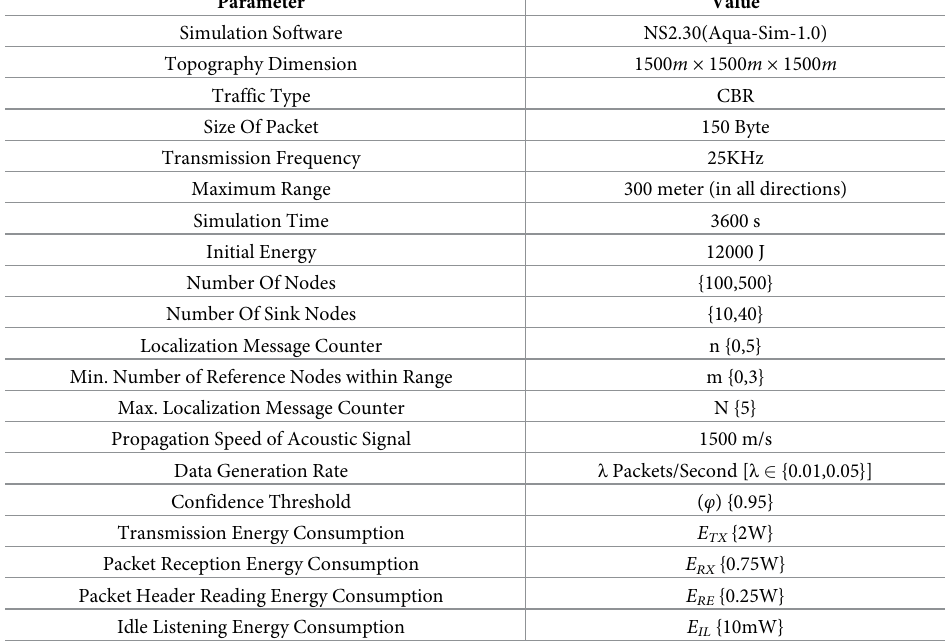
Table 2. Simulation